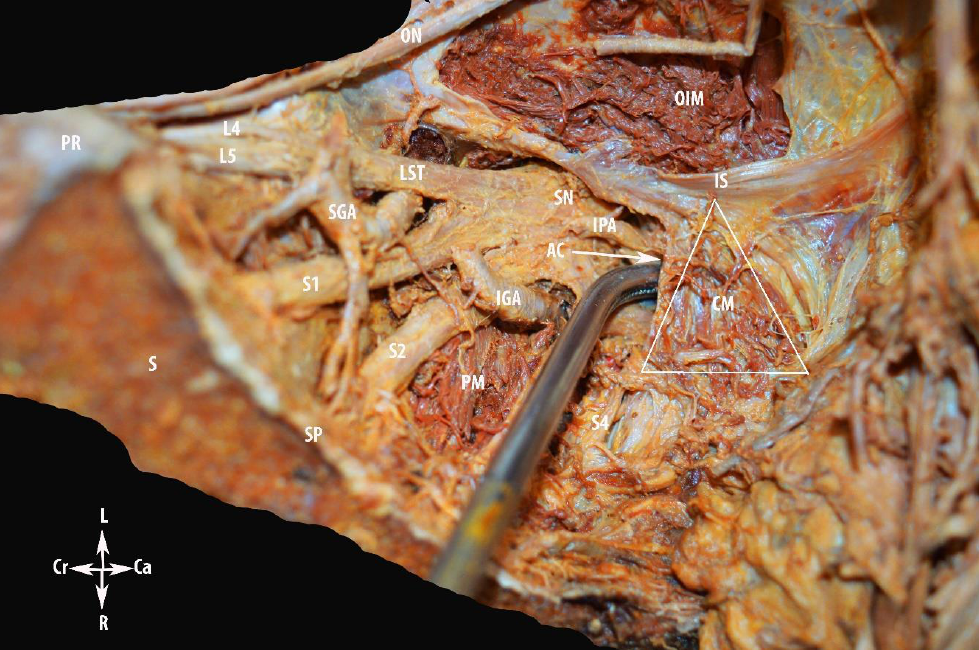
Figure 10. Alcock’s (pudendal) canal. ON — obturator nerve; OIM — obturator internus muscle;